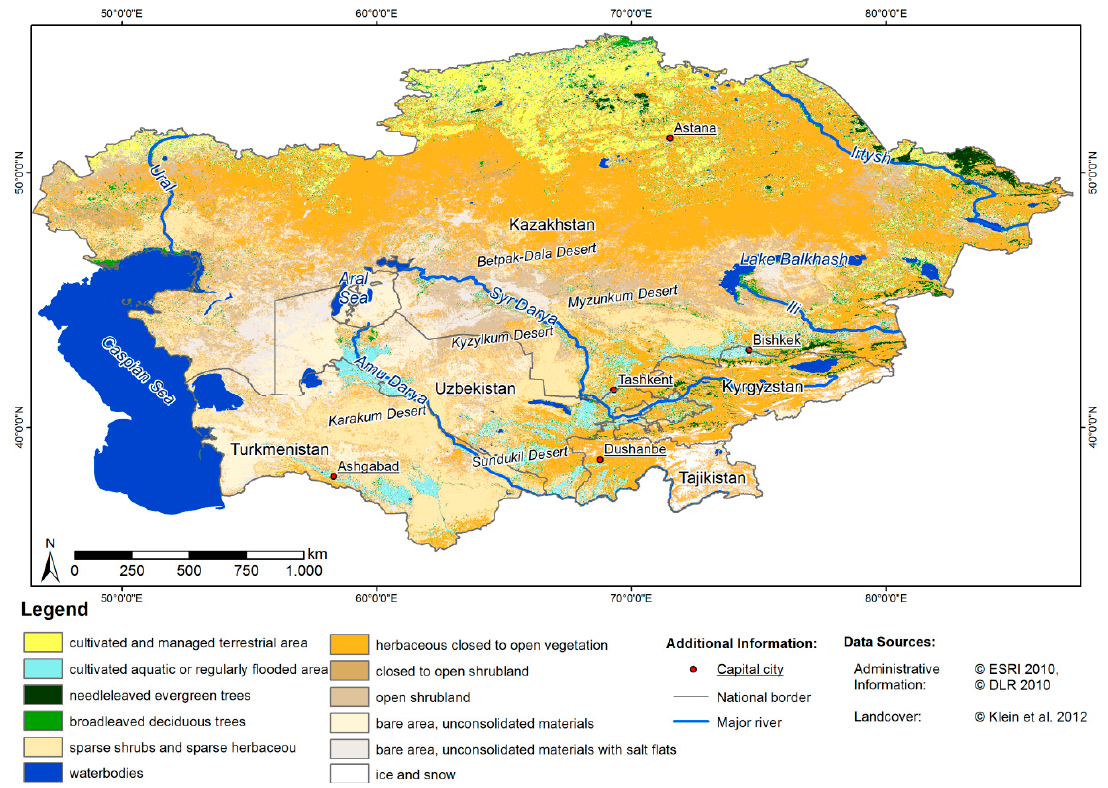
Figure 1. The study area: the post-Soviet Central Asia.